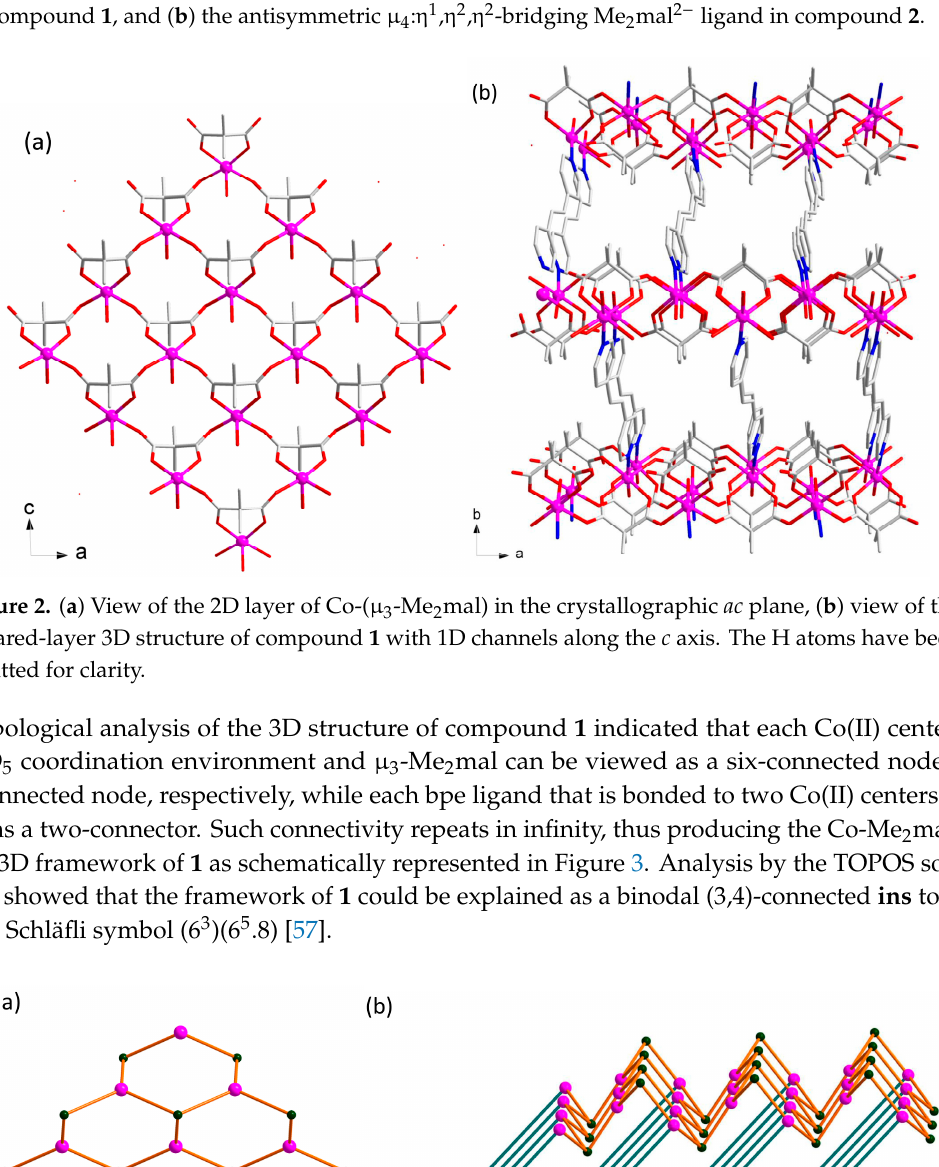
Figure 1. The metal coordination environments of compound 1 . The H atoms have been omitted for clarity. [Symmetry code: ( A ) − 0.5 + x, 1.5 − y, 0.5 + z; ( B ) 0.5 + x, 1.5 − y, 0.5 + z; ( C ) 1 − x, 2 − y, 3 − z].